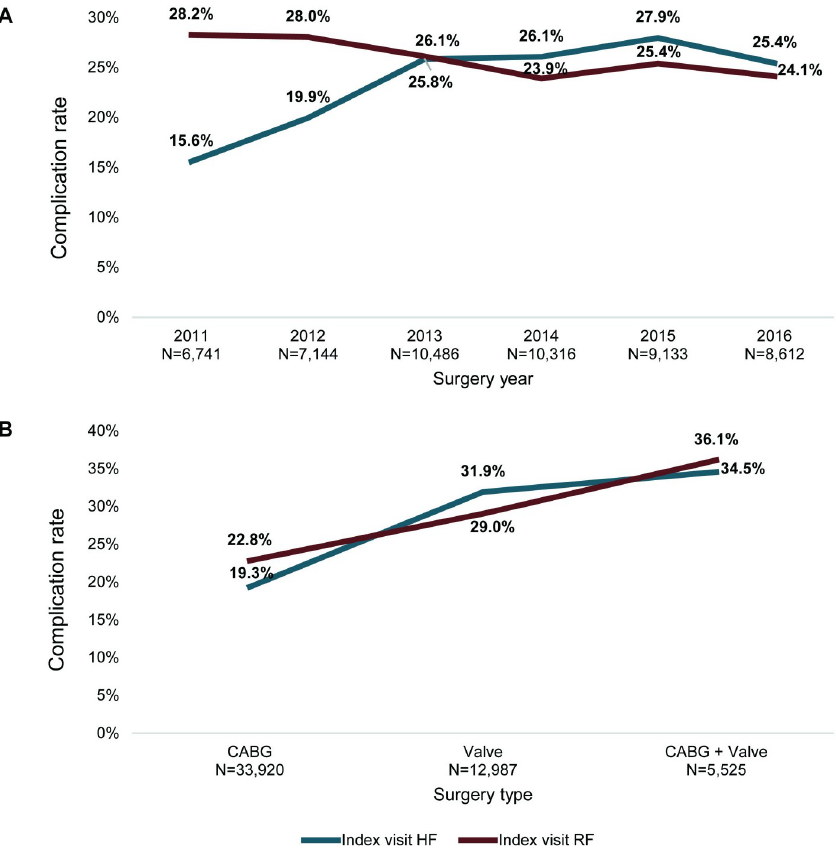
Fig 2. Rates � of heart failure (HF) and respiratory failure (RF) for the index visit by a) surgical year (2011–2016); b) surgical type (CABG, Valve, CABG + Valve) . A) There was a significant difference in the rate of HF and RF over time (p < 0.0001 for each); B) There was a significant association between surgical type (isolated CABG, isolated valve, or CABG + valve) and complication rates for HF or RF (p < 0.001 for each complication). � All rates are expressed as percentages of each